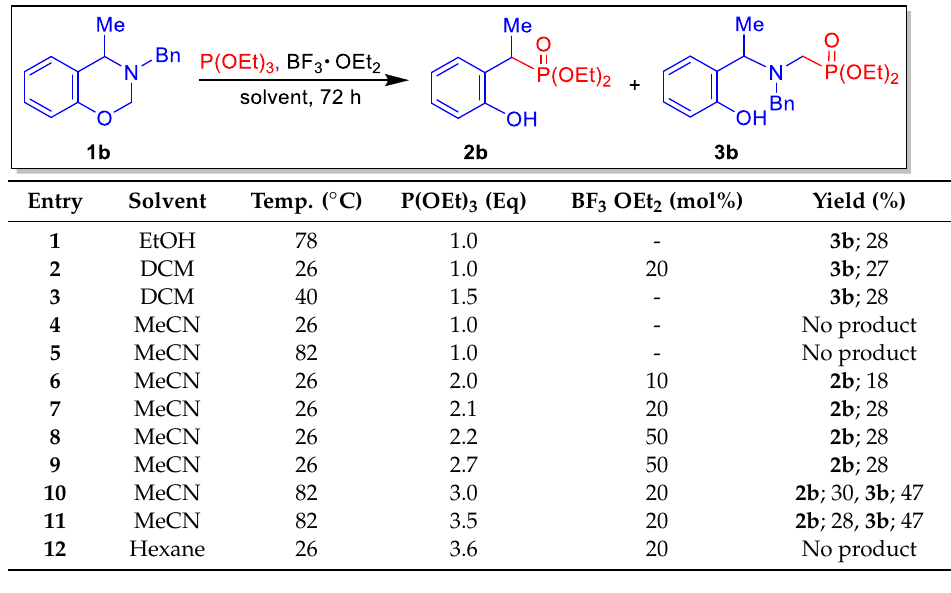
Table 1. Study of the reaction of 1,3-benzoxazine 1b with triethyl phosphite.